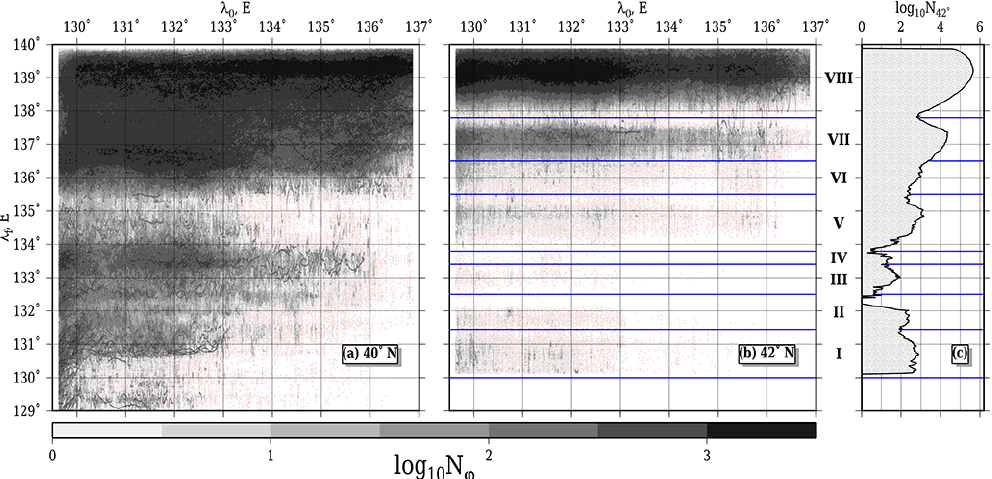
Figure 4. Density plots show in the logarithmic scale how many and at which final longitudes λ f the tracers with initial longitudes λ 0 were able to cross the zonal lines (a) 40 ◦ N and (b) 42 ◦ N for the whole simulation period. The tracers were launched weekly at the line 37 ◦ N from 2 January 1993 to 15 June 2013. (c) Meridional distribution of the number of tracers which crossed the zonal line 42 ◦ N for the whole simulation period. This line is divided into eight intervals numbered by Roman